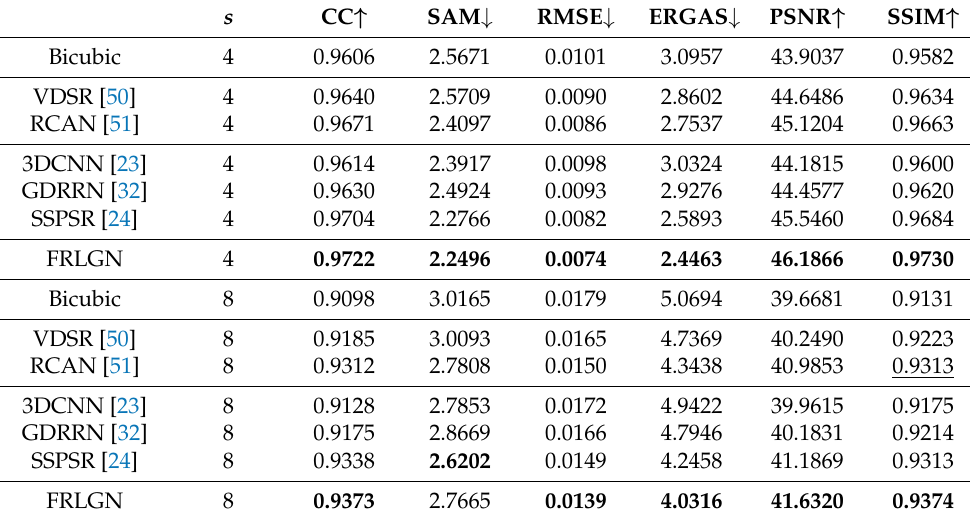
Table 6. Quantitative analysis of seven different comparison methods on Harvard test dataset involving six metrics.